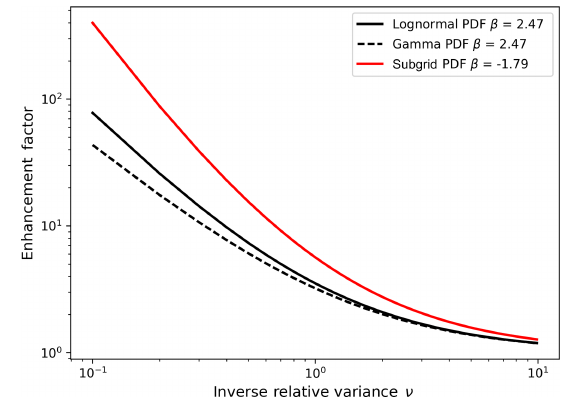
Figure 2. Enhancement factors based on lognormal E(P L , β) and gamma E(P G , β) subgrid PDFs for different β as a function of the inverse relative variance v